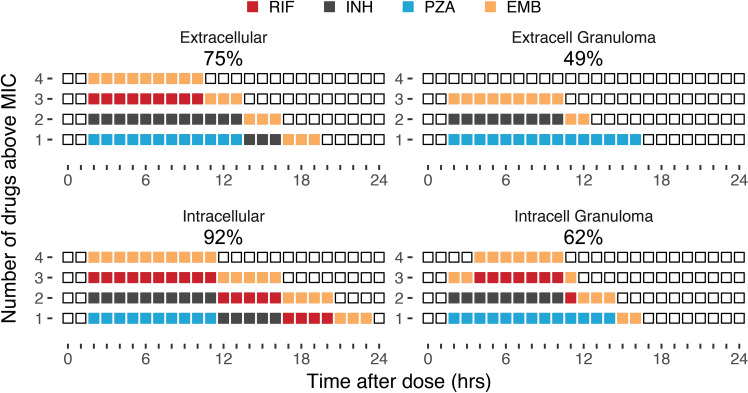
Number of drugs above MIC by compartment.Number of drugs above MIC at steady state of standard therapy drugs at steady state over a 24h dosing interval for 5000 simulated patients. Each colored block represents one hour that a drug is above its MIC. The drugs are stacked for each hour with different colors representing different drugs. Empty squares show no drug on board. The percentage of drug onboard hours vs expected drug hours is shown above each plot to compare total compartment exposure in a 24h period.